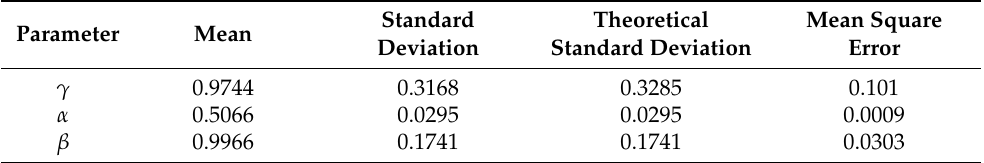
Table 2. Simulation